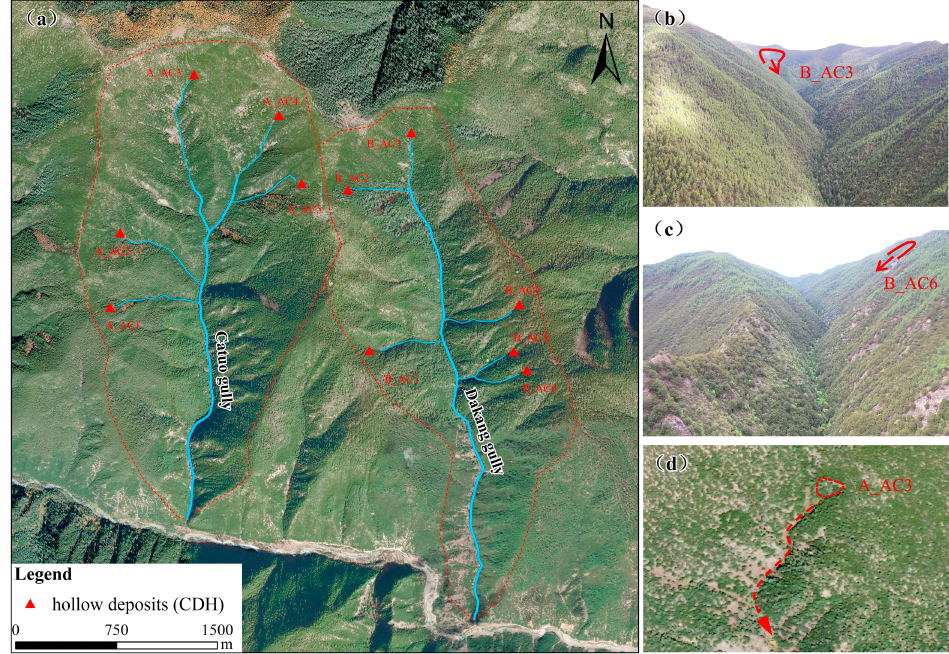
Figure 5. Distribution of CDHs ( a ) in Catuo gully and Dakang gully, ( b ) AC3 in Dakang gully, ( c ) AC6 in Dakang gully, ( d ) AC3 in Catuo gully.